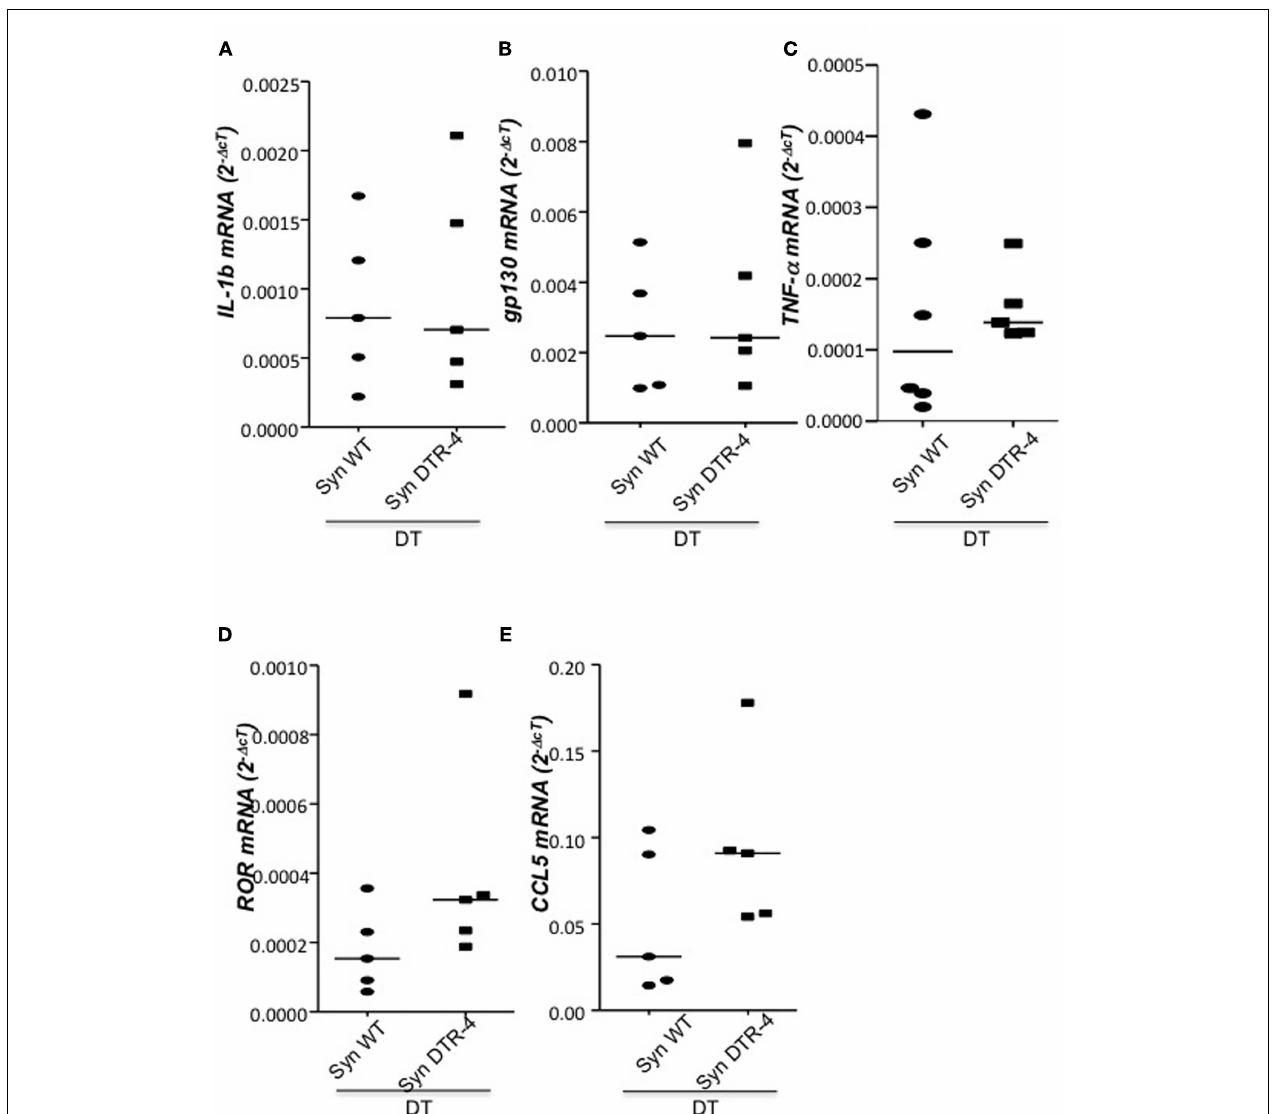
FIGURE 5 | Depletion of Tregs does not provoke changes in the levels of IL-1b, gp130,TNF- α , ROR- γτ , or CCL5 . In samples from Foxp3.LuciDTR-4 or wild type animals treated with DT by daily application starting on day 2 and further mated allogeneically, inflammation markers were measured ( n = 4–6/group) in uterine tissue by qPCR. Levels of IL-1b (A) , gp130 (B) ,TNF- α